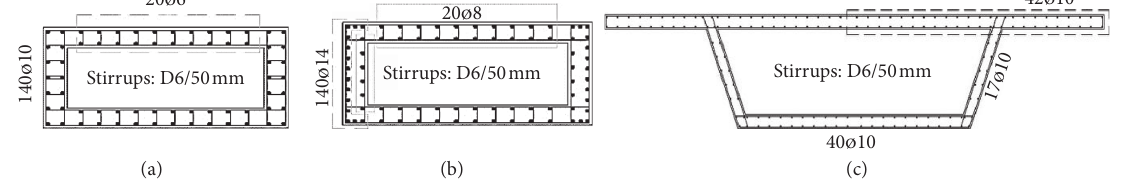
Figure 6: Reinforcement details of the numerical study [7]. Table 1: Material properties of the numerical model.